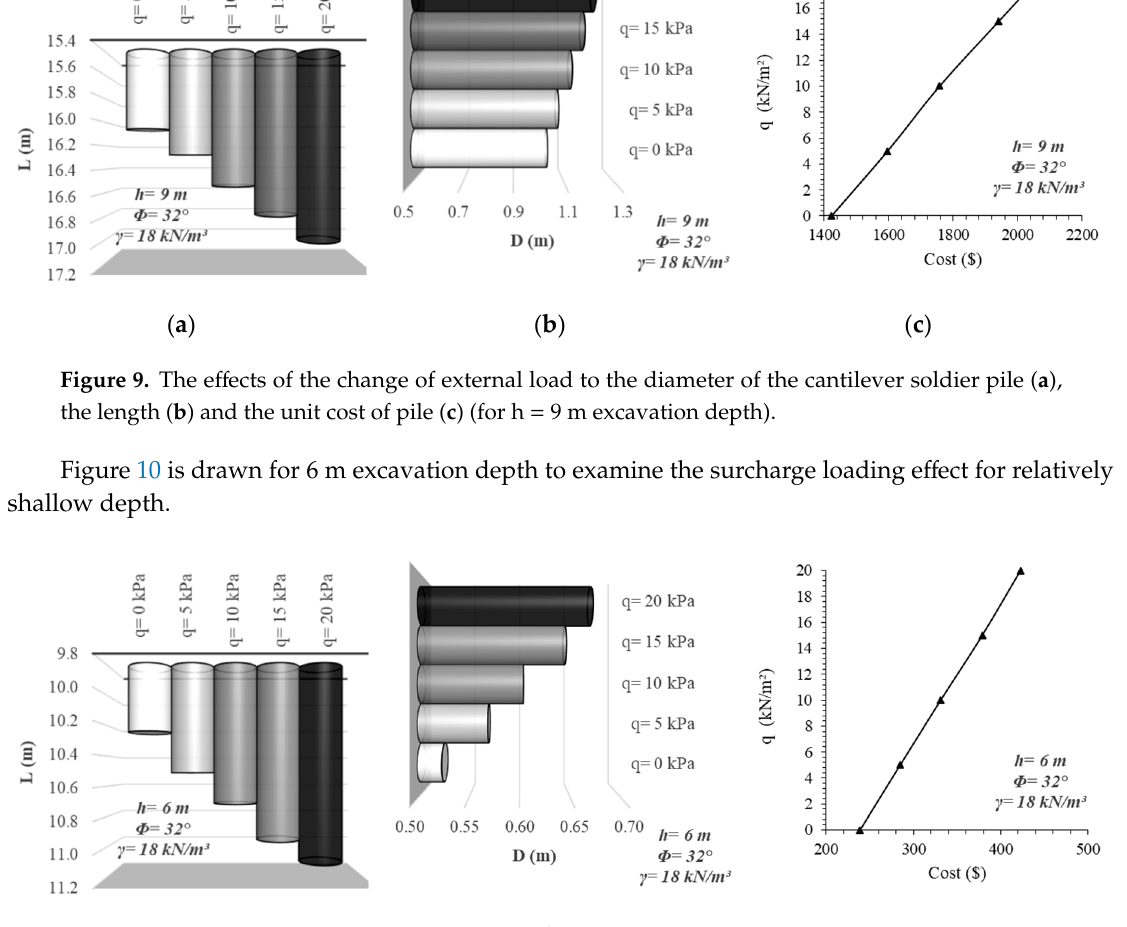
Figure 8. The effects of the change of soil unit weight to the diameter of the cantilever soldier pile ( a ), the length ( b ), and the unit cost of pile ( c ) (for h = 6 m excavation depth) via the excavation depth.